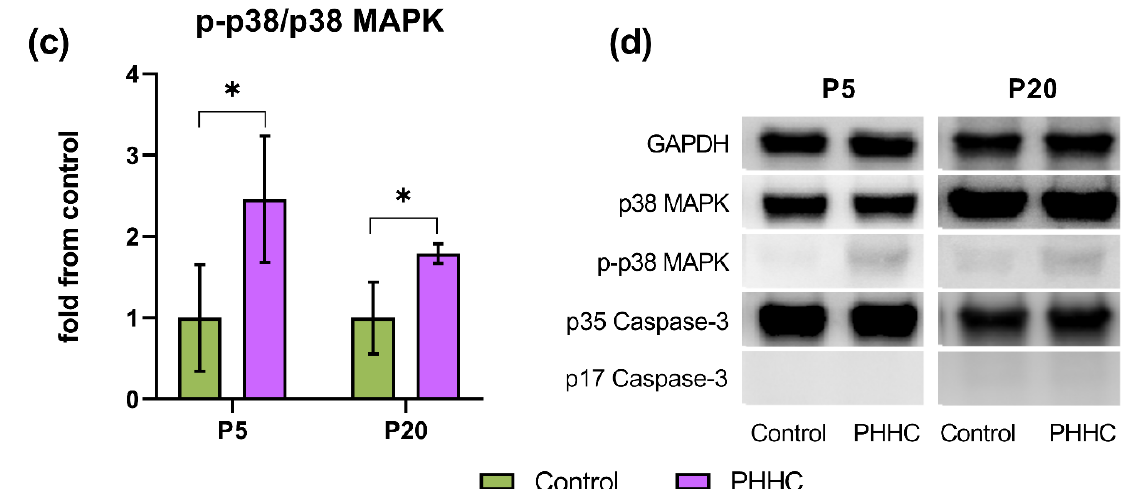
Figure 6. Effects of maternal hyperhomocysteinemia on caspase-3 and p38 MAPK in the hippocampus of the pups on P5 and P20. PHHC, prenatal hyperhomocysteinemia. ( a ) Band density of p35 caspase-3 content in the hippocampus of rats on P5 and P20 in the control ( n = 12–13) and PHHC ( n = 13–15) groups determined by densitometry analysis. ( b ) Caspase-3 activity in the hippocampus of the rats on P5 ( n = 6–8) and P20 ( n = 10) in the control and PHHC groups. Samples were run in duplicate. ( c ) The ratio of phospho-p38 (p-p38) and total p38 MAPK content in the hippocampus of the rats on P5 ( n = 4–5) and P20 ( n = 4–5) in the control and PHHC groups determined by densitometry analysis. ( d ) Representative Western blots are shown for each condition. Western blot data for each age are normalized to the appropriate control group for comparison. Data are presented as mean ± SD. Significance of difference between the PHHC and control groups were determined by the Student’s t -test (* p ≤ 0.05).